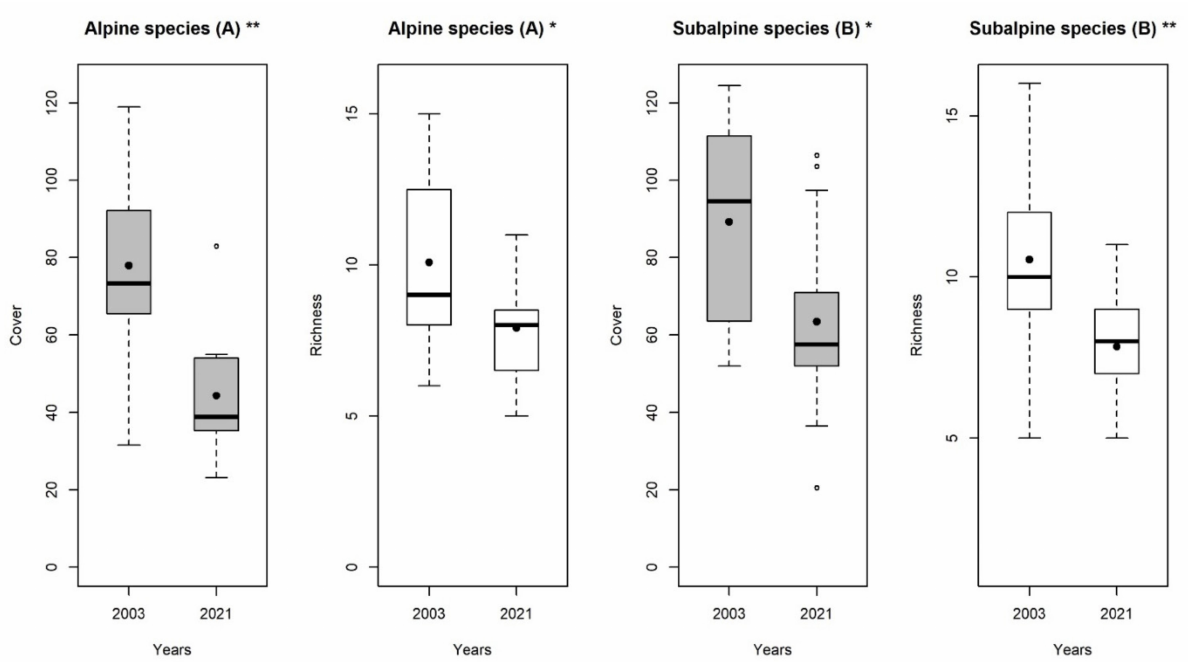
Figure 4. Boxplot comparing cover (grey) and richness per 4 × 4 m plot (white) of alpine species (T: 1–1.5) and subalpine species (T: 2–2.5) in two time steps (T1: 2003 and T2: 2021) in Apennine stripped grassland (A) and wind edge swards (B). Only the significant results are reported. Asterisks indicate significant differences according to the Kruskal–Wallis test for equal medians (* p < 0.05, ** p < 0.01).